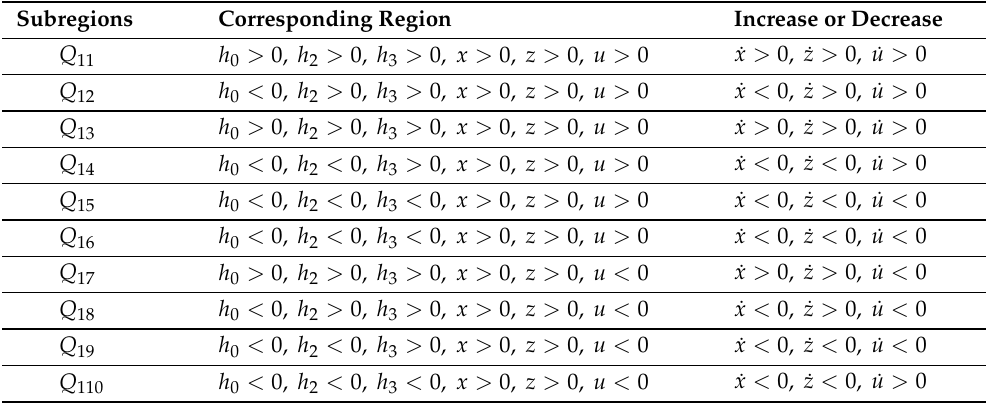
Table 11. Dynamical behavior in the ten subregions. Subregions Corresponding Region Increase or